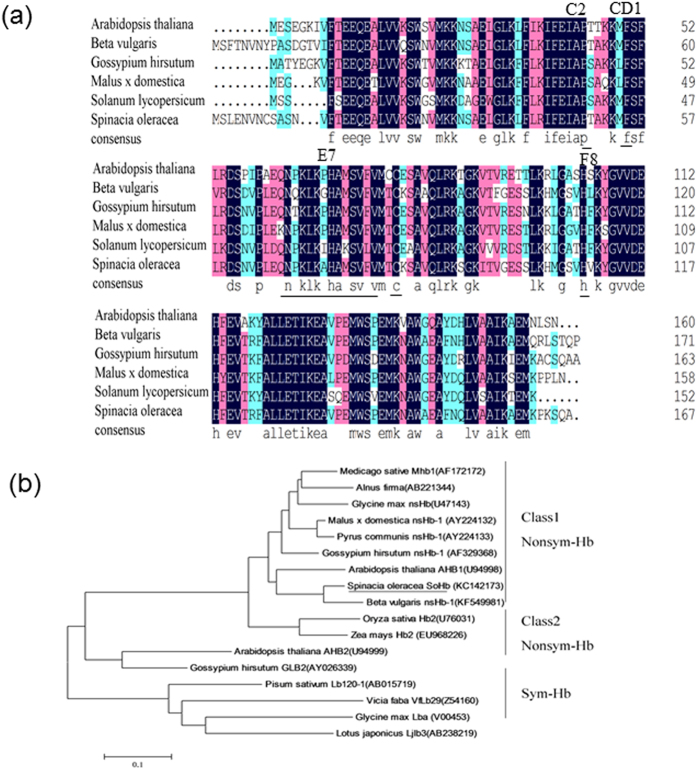
Analysis of the deduced amino acid sequence of SoHb.(a) Multiple sequence alignment of SoHb. Alignment of the predict SoHb protein with other Hb proteins from different plants. Conserved residues of heme- and ligand-binding (distal (E7) and proximal (F8) His residues, Phe (CD1), Pro (C2)) are underlined. Cys residues are also underlined. The protein sequences shown in the diagrams were listed in the GenBank database under the following accession numbers: Spinacia oleracea (Acc. No. KC142174); Beta vulgaris (Acc. No. KF54998); Arabidopsis thaliana (Acc. No. AK227823); Malus×domestica (Acc. No. AY224132); Gossypium hirsutum (Acc. No. AF329368); Solanum lycopersicum (Acc. No. NM001247569). (b) Phylogenetic analysis of SoHb together with the other plant nsHbs. The phylogenetic tree for Hb from different plant species were constructed on the basis of the multiple alignments of deduced amino acid sequences performed using ClustalW with default parameter settings and computed using the NJ method in the MEGA 6. The database accession numbers were indicated in parentheses after plant names.